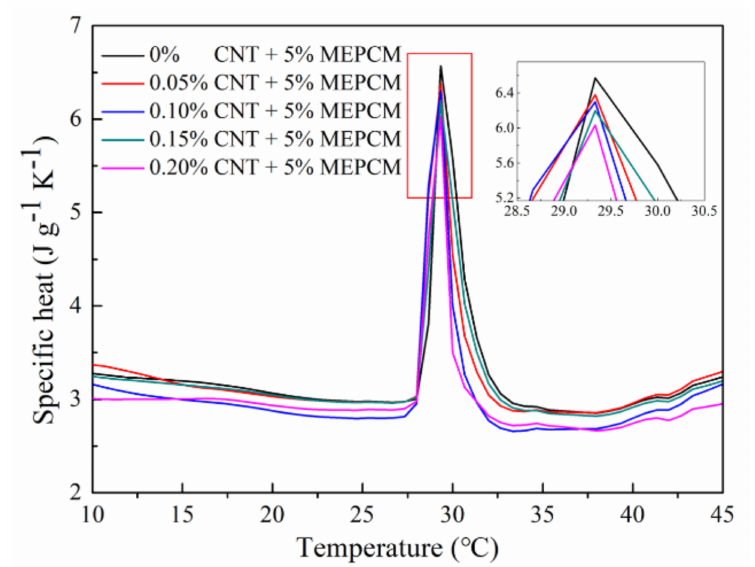
Figure 9. Specific heat capacity curves of MEPCM / CNT suspension with di ff erent CNT concentrations.